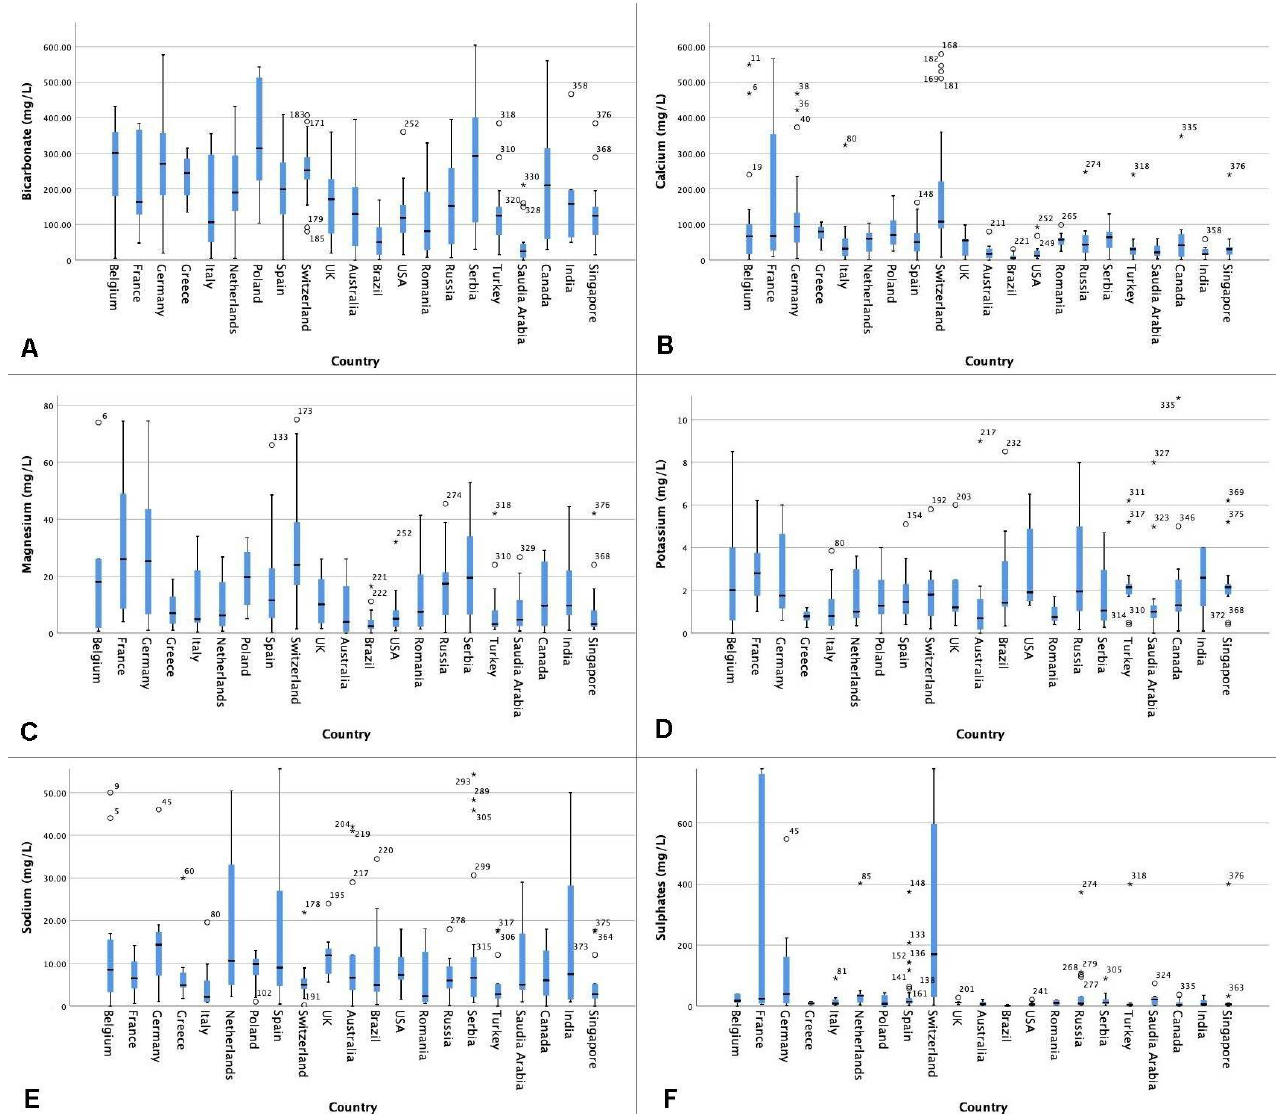
Figure 1. ( A–F ): The mineral composition of bottled still water (mg/L) per mineral by country. ° Outlier. * Extreme value.